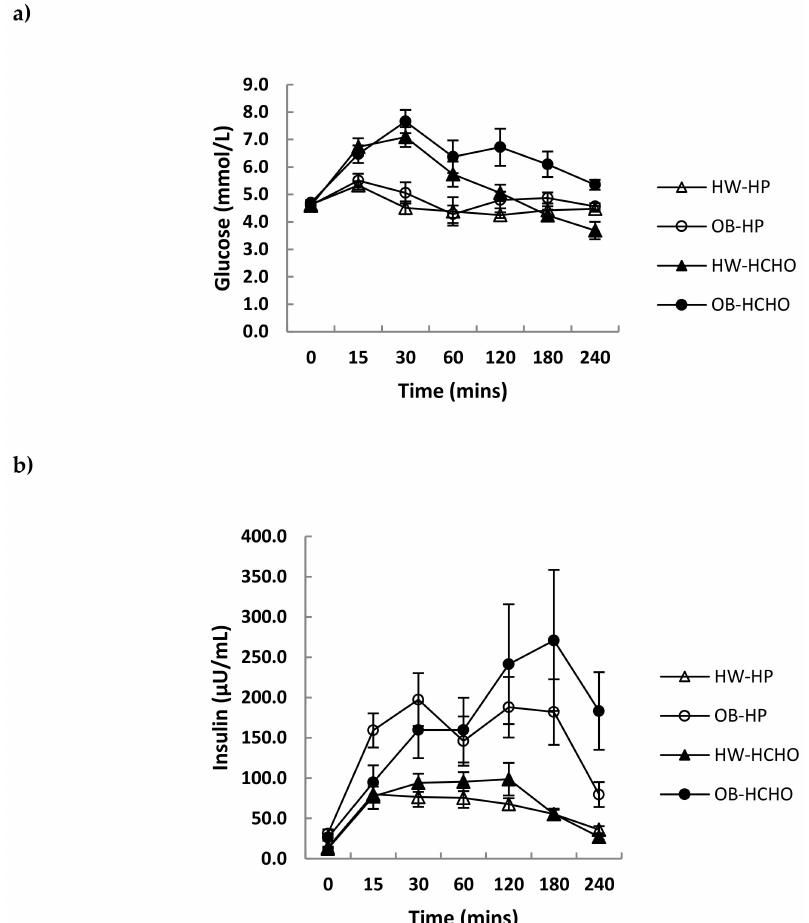
Figure 4. Changes in plasma glucose and insulin concentrations over time after a high-protein (HP) and high-carbohydrate meal (HCHO) in adolescents with obesity (OB) n = 8 and of healthy weight (HW) n = 12. ( a ) glucose: Time × meal × weight interaction ( p = 0.003), ( b ) insulin: Time × meal × weight interaction ( p = 0.018). Data analysed using a mixed between–within-subjects analysis of variance. Data are presented as means